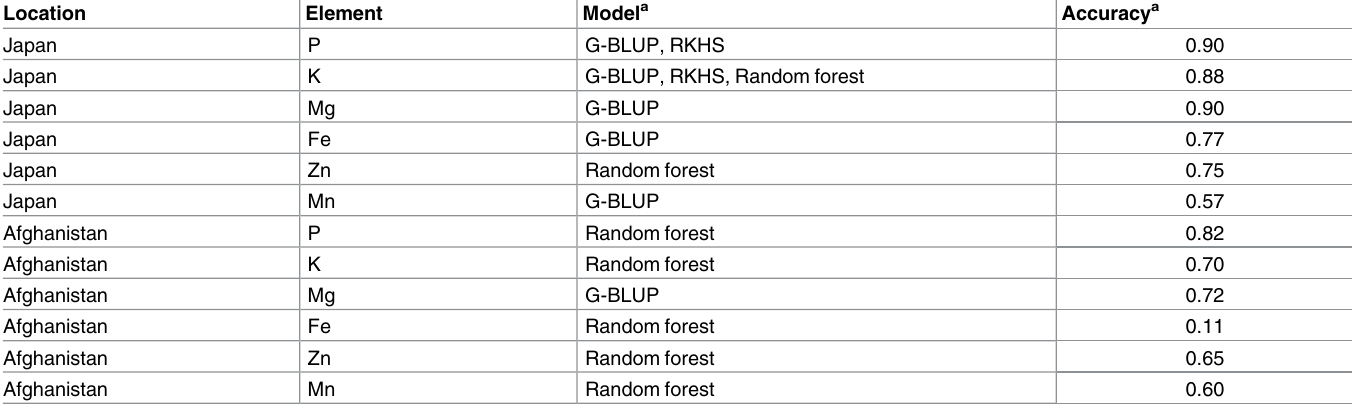
Table 5. Adjusted accuraciesof genomic